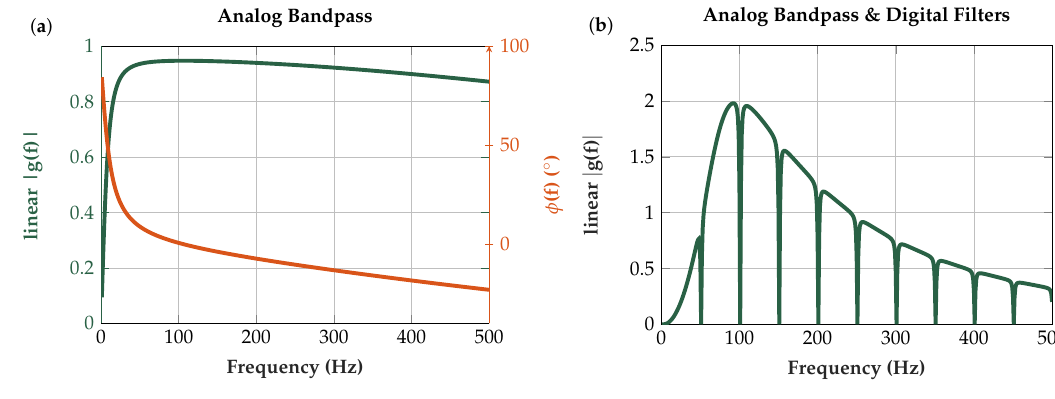
Figure 15. ( a ) Transfer function of the first-order analog bandpass ( f C : 11–1064 Hz); and ( b ) combined transfer function of analog bandpass and digital signal processing. The digital signal processing includes a second-order highpass with 60 Hz cutoff frequency and a second-order notch filtering 50 Hz and its harmonics. A lowpass follows after the highpass and notch to eliminate high-frequency noise [53].